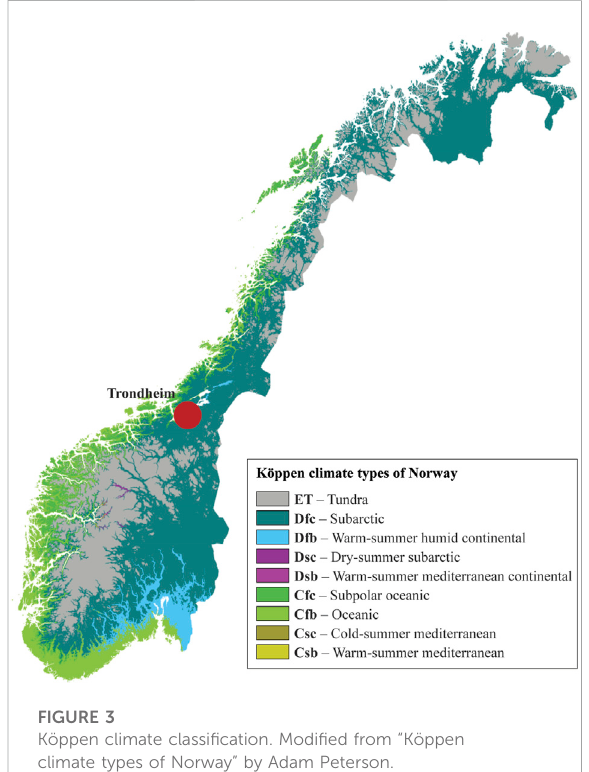
FIGURE 3 Köppen climate classi fi cation. Modi fi ed from “ Köppen climate types of Norway ” by Adam